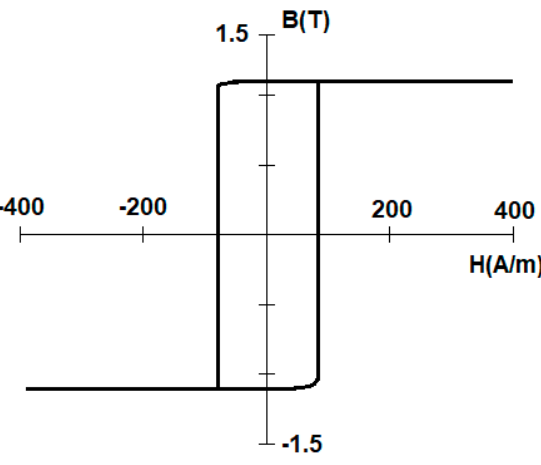
Figure 1. Rectangular hysteresis loop of used amorphous wire [10].